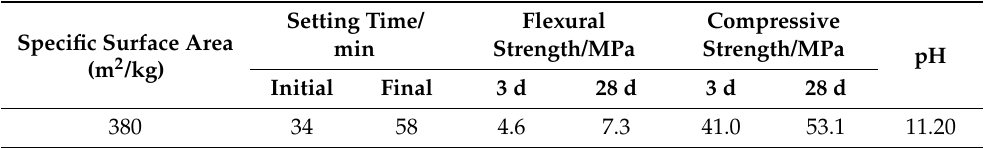
Table 3. Granulated ground blast slag performance test results.